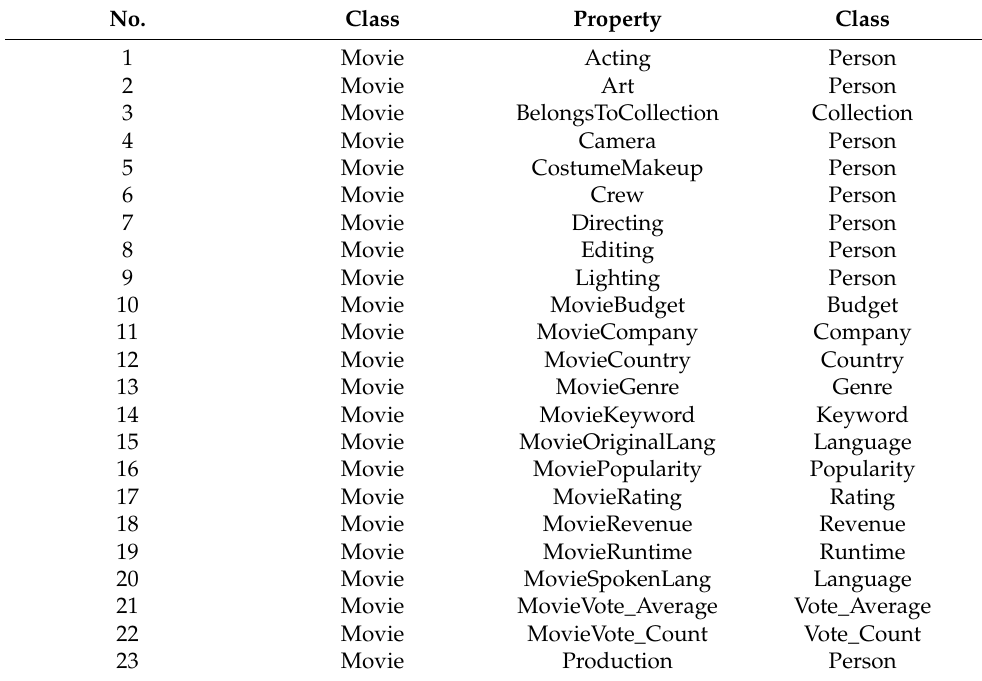
Table 5. Ontology schema used in the